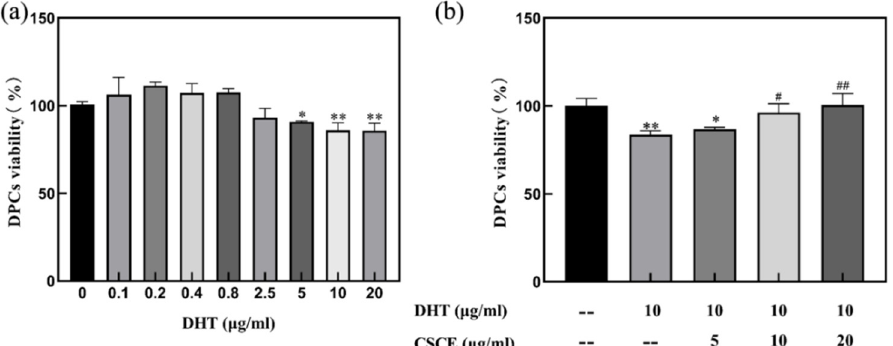
Figure 2. Cell viability of DPCs. ( a ) Viability of DPCs treated with different concentrations of DHT. ( b ) The effect of CSCE on DHT-induced cell damage in DPCs. (Compared with blank control group, * p < 0.05, ** p < 0.01; compared with 10 μ g/mL DHT group, # p < 0.05, ## p < 0.01).